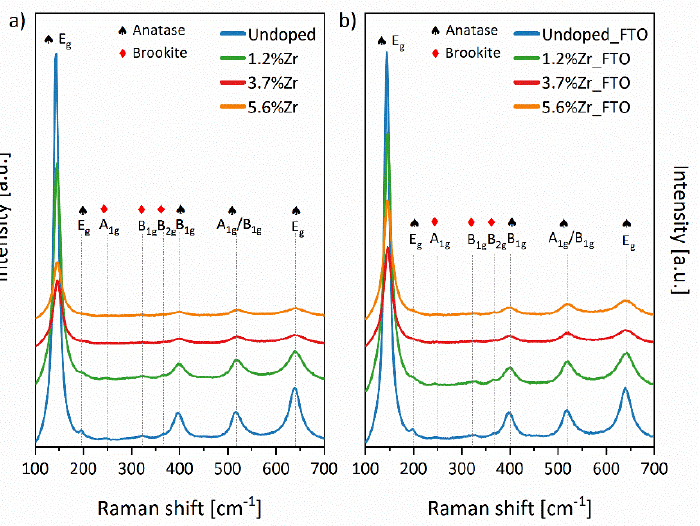
Figure 5. Raman spectra of TiO 2 nanopowders ( a ) and FTO nanoparticles ( b ) annealed at 450 °C for 2 h.